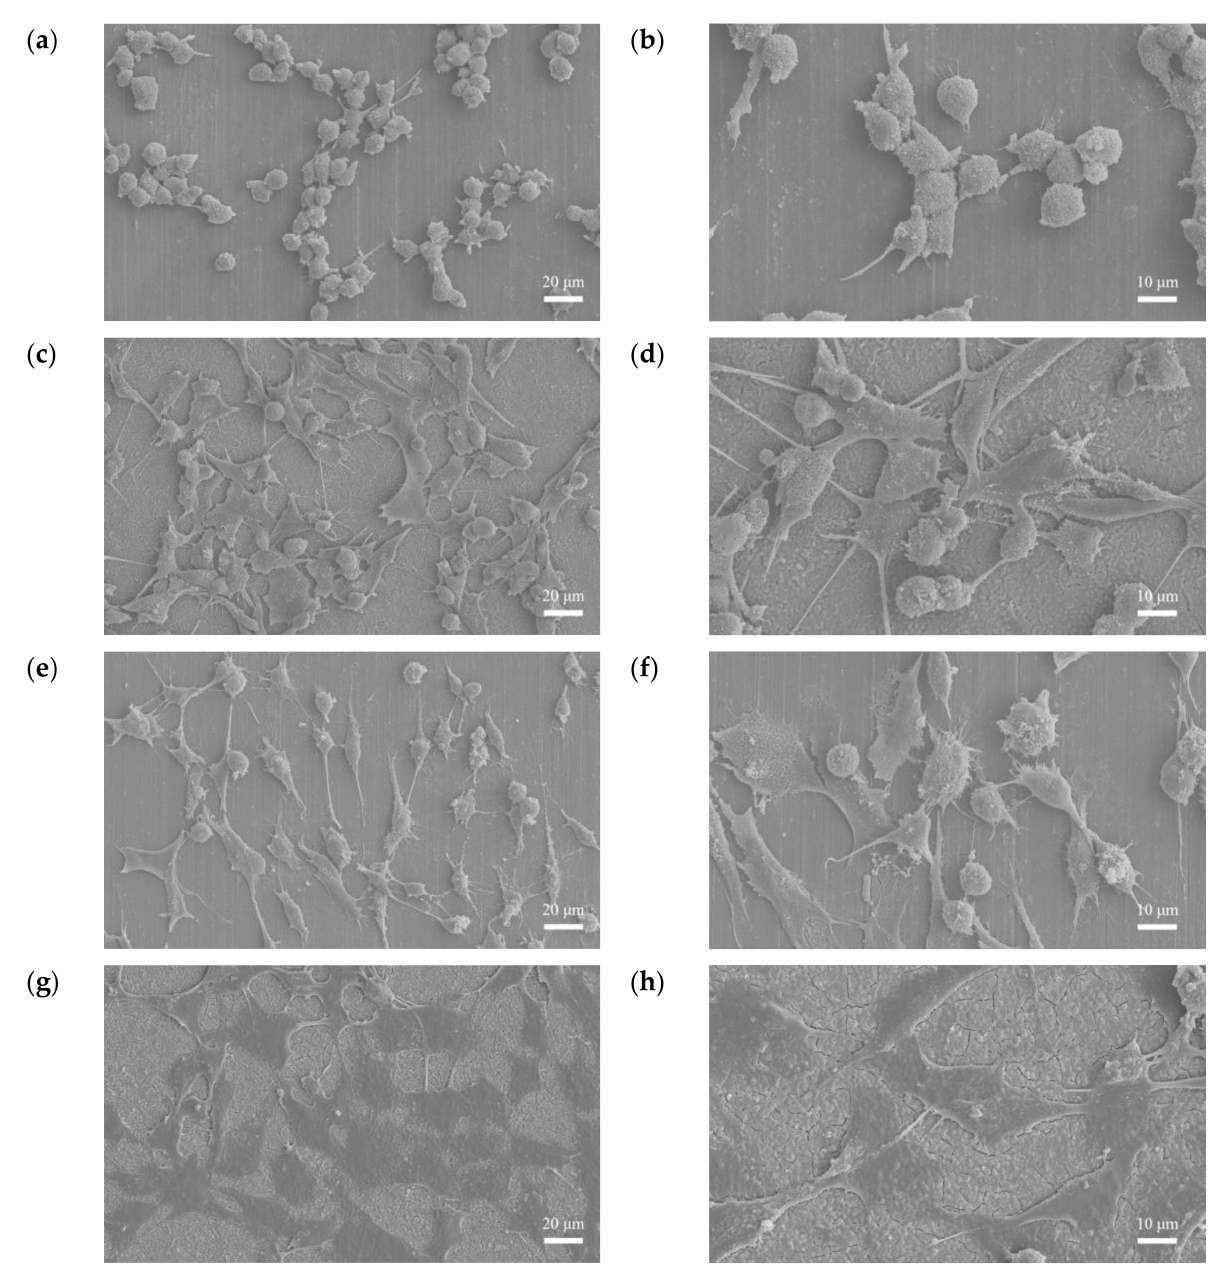
Figure 19. Cell adhesion results: ( a , b ) F-3 h, ( c , d ) FP-3 h, ( e , f ) F-24 h, and ( g , h ) FP-24